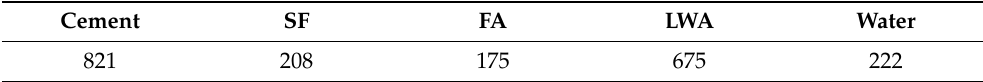
Table 3. Benchmark mix proportion of L-UHPC (kg/m 3